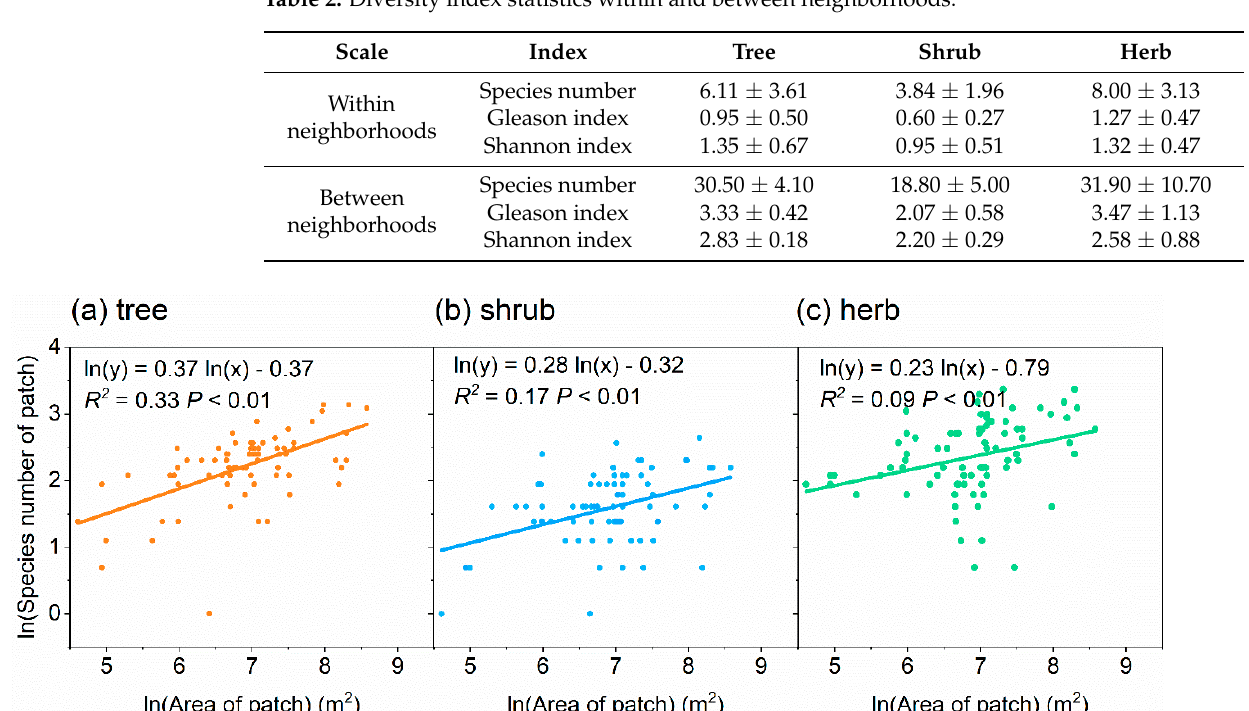
Figure 2. The percentage of species were found ( a ) in one, more than 50% and all patches within neighborhoods and ( b ) in one, more than 50% and all neighborhoods investigated. Table 2. Diversity index statistics within and between neighborhoods.